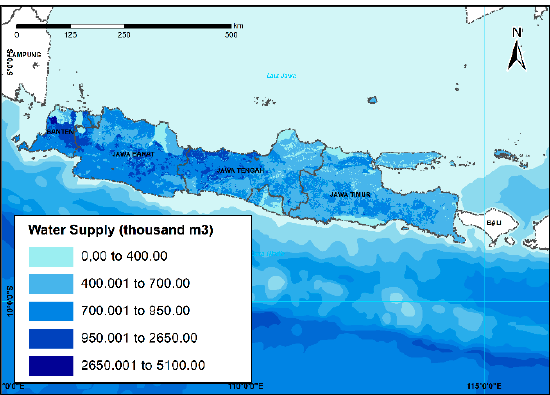
Figure 5. The water supply.